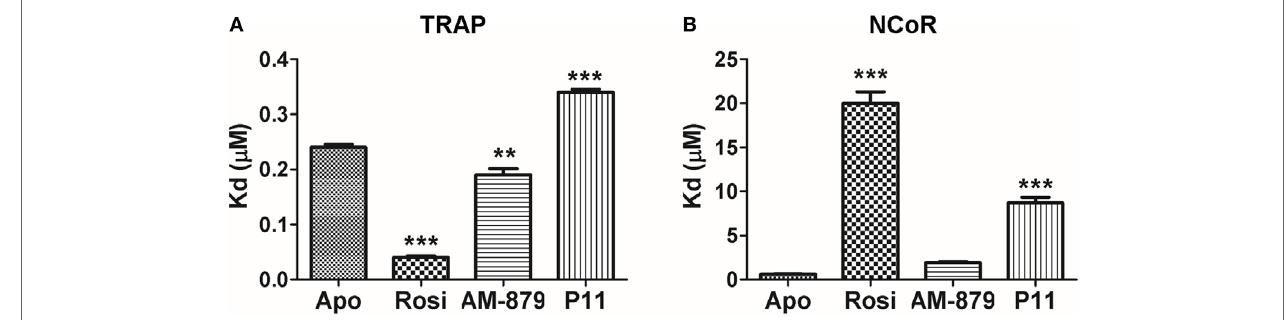
FigUre 4 | In vitro r ecruitment of coregulators by peroxisome proliferator-activated receptor gamma (PPAR γ ) in the presence of AM-879 and P11. (a) Dissociation constants (Kds, μ M) between PPAR γ ligand-binding domain (LBD) and TRAP coactivator peptide in the absence (Apo) or in the presence of the ligands Rosiglitazone (Rosi), AM-879 and P11. (B) Kd ( μ M) between PPAR γ LBD and NCoR corepressor peptide in the absence (Apo) or in the presence of ligands. Kds were determined from ligand-binding curves (until 20 µM), obtained by fluorescence anisotropy measurements using fluorescein labeled TRAP (ID2) or NCoR (ID2) peptides (20 nM). Data are the mean ± SEM ( n = 3, ** p < 0.05, *** p < 0.001 vs